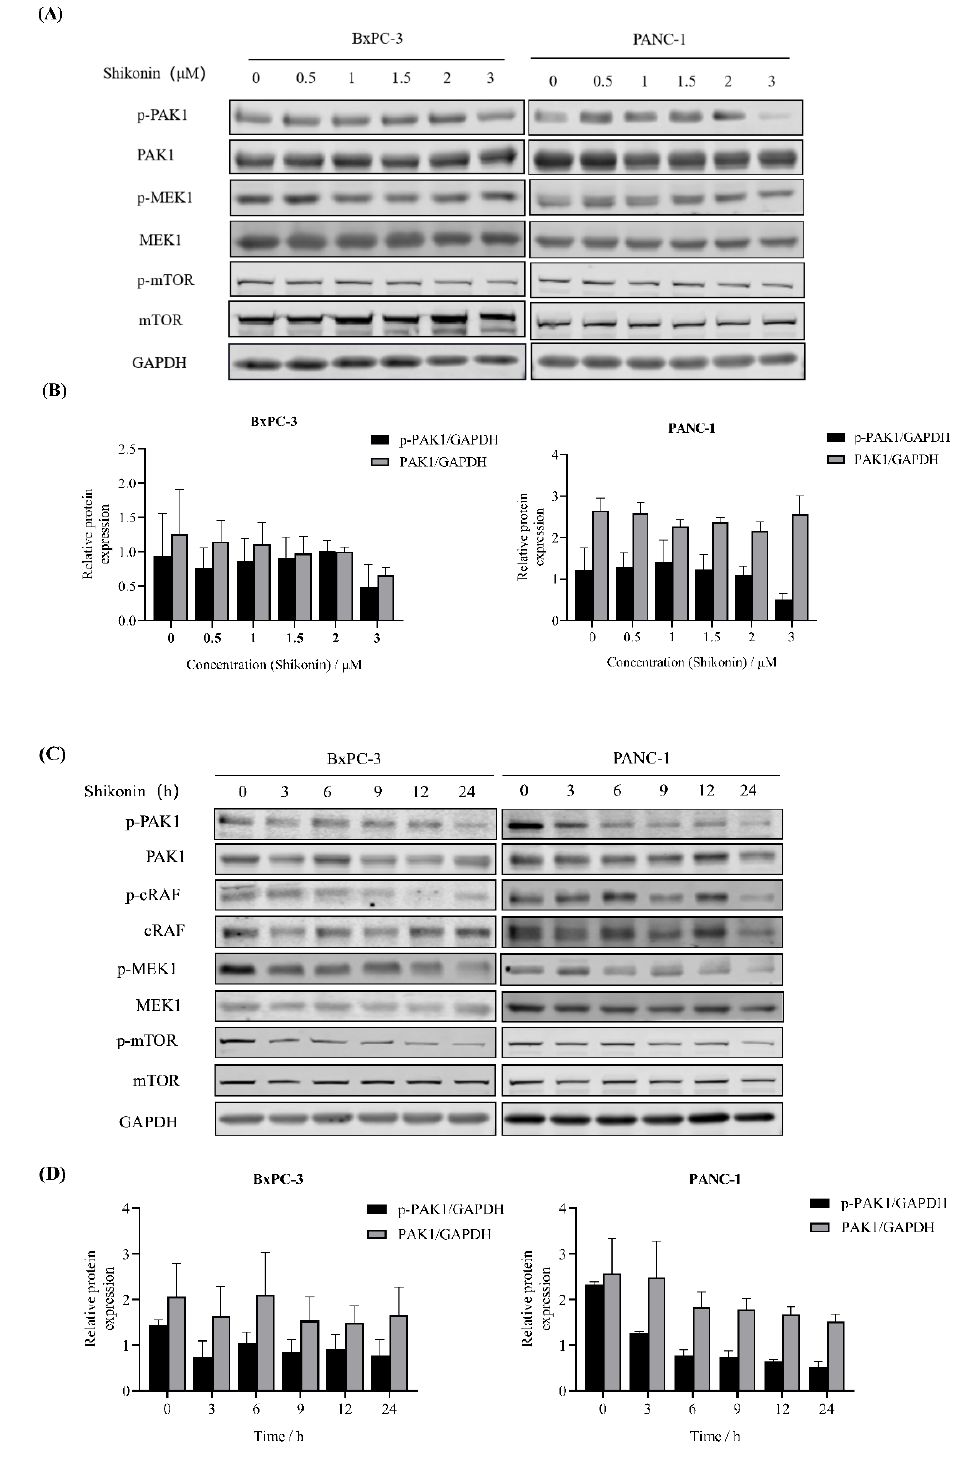
Figure 4. Shikonin inhibits PAK1-related signaling pathways in pancreatic cancer cells. ( A ) BxPC − 3 and PANC − 1 cells were treated with shikonin for indicated concentrations, and Western blot assay was conducted using indicated antibodies. ( B ) The expression of p − PAK1 and PAK1 was quantified by densitometry analysis and normalized against GAPDH. ( C ) BxPC − 3 and PANC − 1 cells were treated with shikonin for indicated time points, and Western blot assay was conducted using indicated antibodies. ( D ) The expression of p − PAK1 and PAK1 was quantified by densitometry analysis and normalized against GAPDH. The experiments were conducted at least